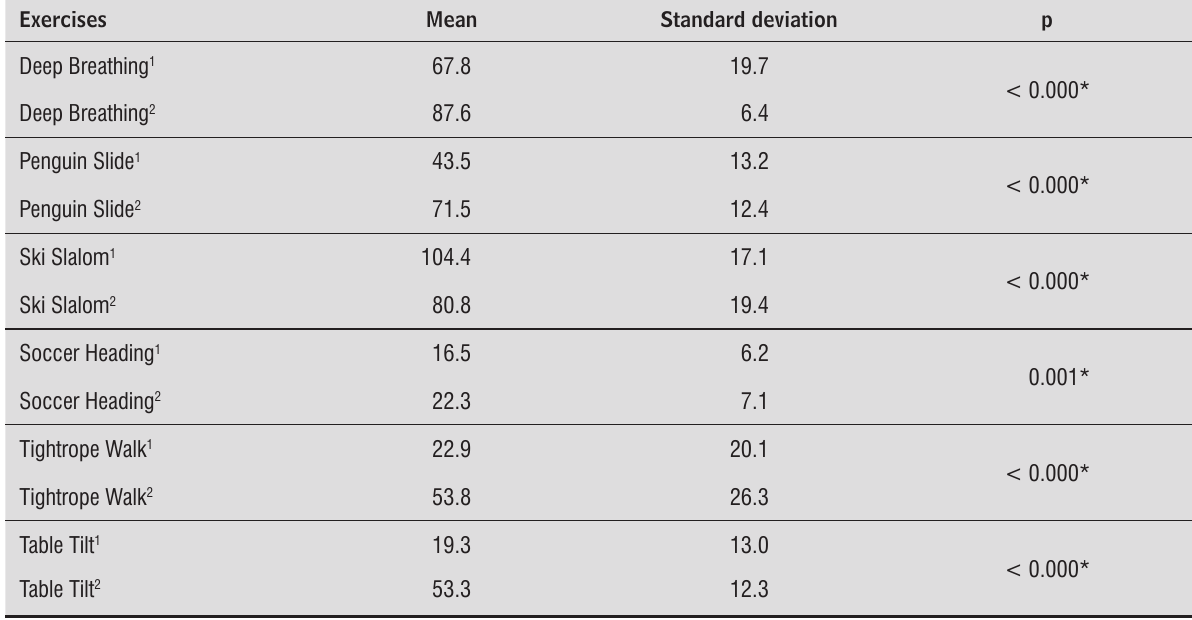
Table 3 - Analysis of exercises done in the 1 st and 20 th